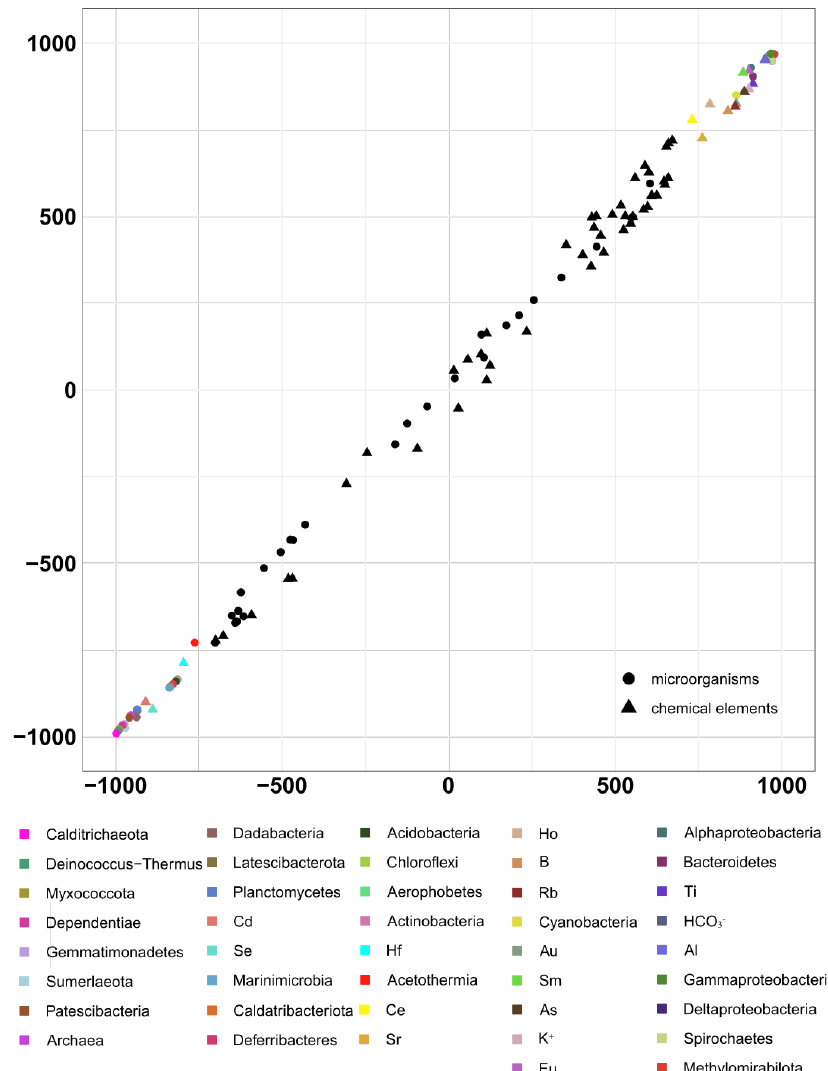
Figure 10. Results from the analysis of the second pair of datasets by the 2B-PLS method. Results on taxonomic composition (according to phyloFlash) and the geochemical factors potentially affecting it. B1: Axis 1: geochemical datasets, B2: Axis 1: taxonomical datasets.